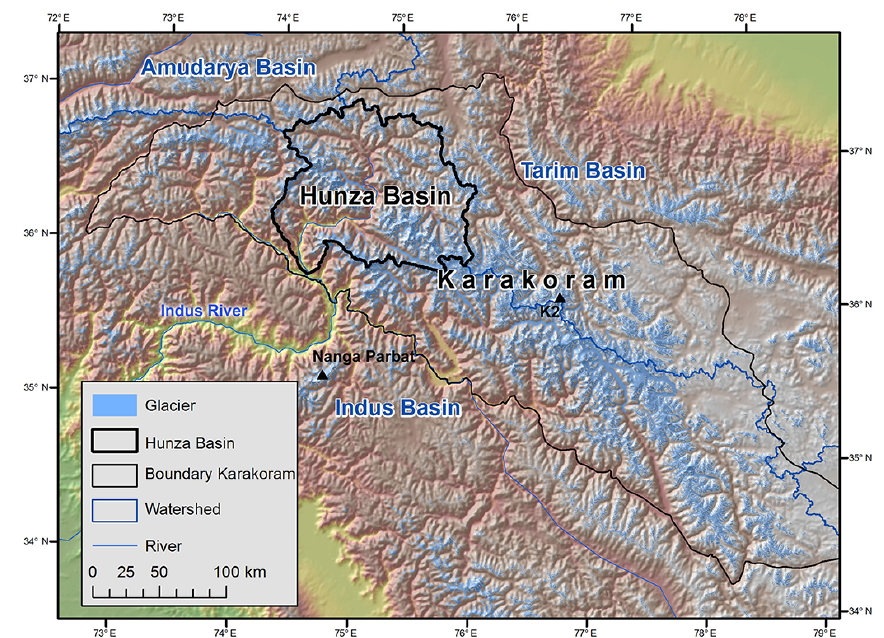
Figure 1. Overview map of the study